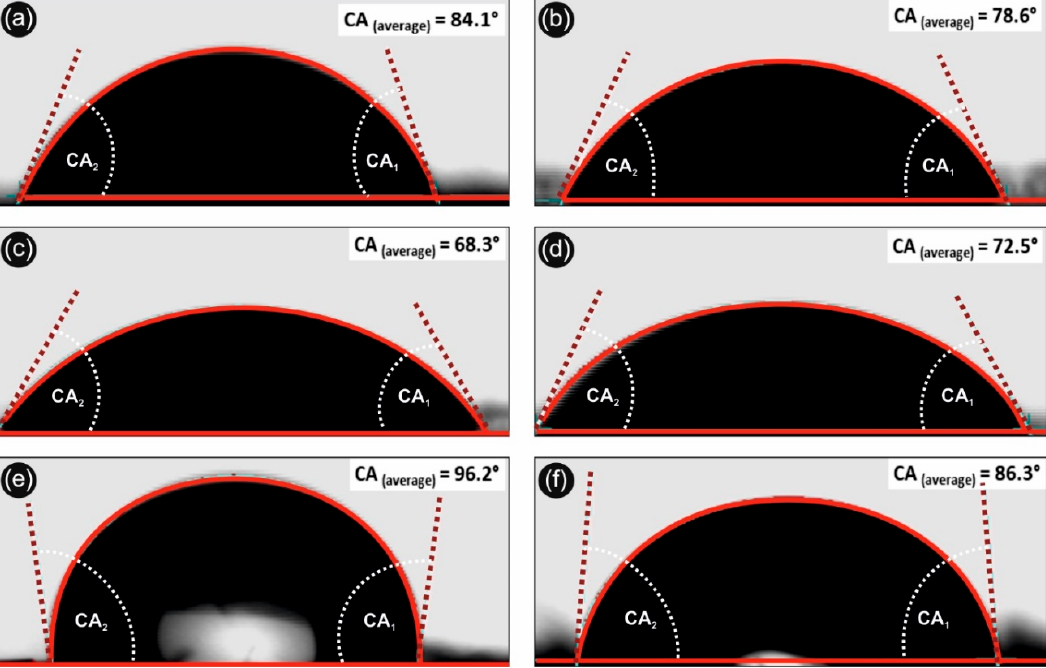
Figure 5. Water contact angle profiles of neat PLA, PLA/Ag/PEG (rec-01), and PLA/Ag/PVP (rec-03) 3D printed samples at 300 and 100 µm printed layer thickness, respectively, showing the hydrophobic and anti-adhesive properties of the different 3D printed objects in this work (CA 2 : contact angle 2; CA 1 : contact angle 1; CA average : contact angle average value in “°” from CA 1 and CA 2 ). ( a , b ): H 2 O contact angle of neat 3D printed PLA with 100 and 300 µm printed layer thickness, respectively. ( c , d ): H 2 O contact angles of PLA/Ag/PEG (rec-01) with 100 and 300 µm printed layer thickness, respectively. ( e , f ): H 2 O contact angle of PLA/Ag/PVP (rec-03) with 100 and 300 µm printed layer thickness, respectively.